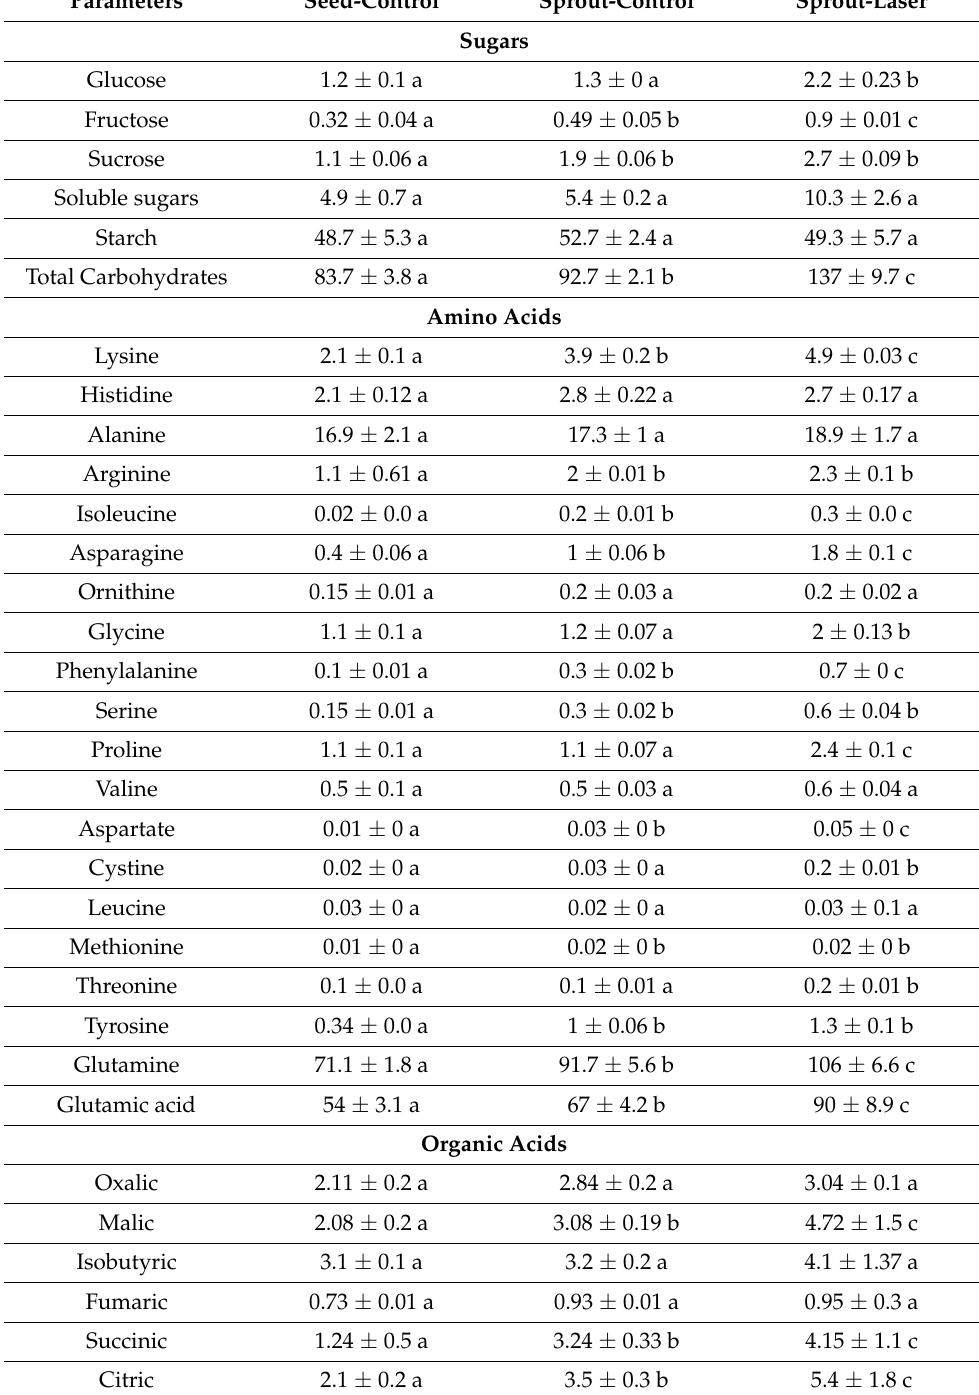
Table 3. Effect of He-Ne laser light treatment on sugar, amino acid, and organic acid contents in Cymbopogon proximus sprouts and seeds. Data are represented by means ± standard